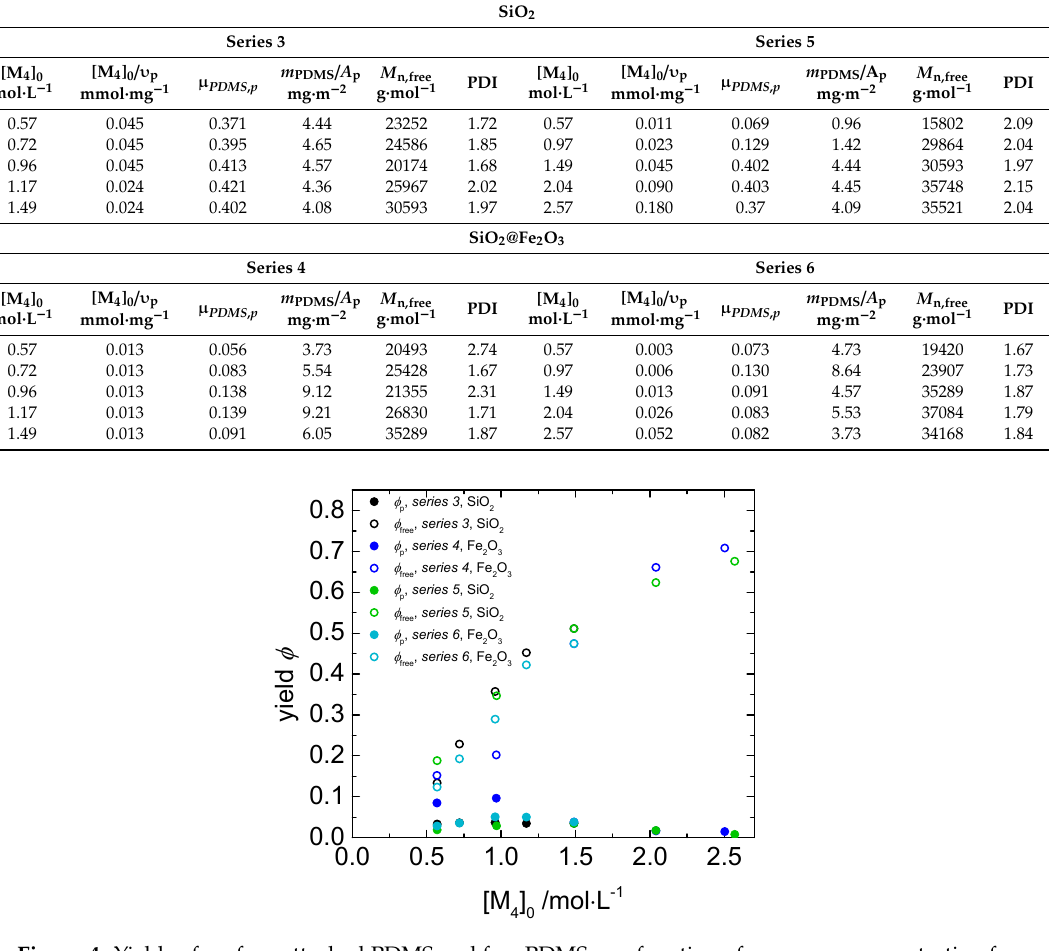
Figure 4. Yields of surface-attached PDMS and free PDMS as a function of monomer concentration for the SI–ROP of M 4 on SiO 2 and on SiO 2 @ α -Fe 2 O 3 obtained in Series 3 to 6.